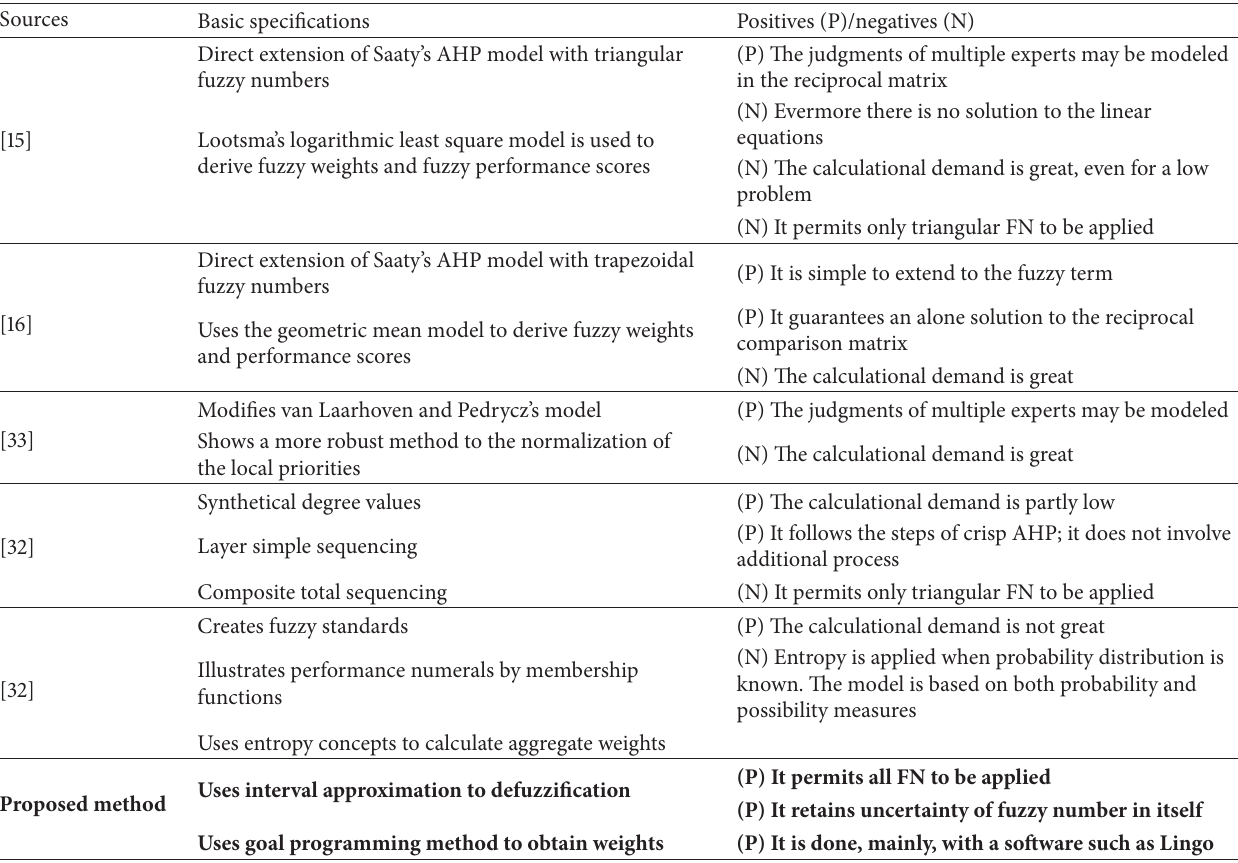
Table 21: The comparison of various FAHP models [30, 31].